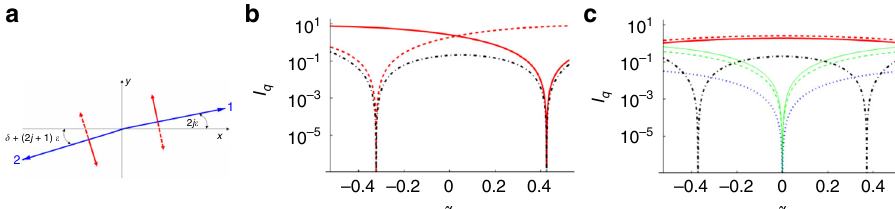
Fig. 6 Model predictions for the bilayer structure. a Molecules in the successive layers differ in the direction of the long molecular axis. The fi gure shows * the projection of the director n on the smectic plane ( xy -plane) in the jth stack of two successive layers; on the nearly anticlinic structure of the director in the neighboring layers, the additional rotation by angle ε is superimposed. Thick red (solid or dashed) arrows denote the direction of the molecular tip when the tilt is perpendicular to the tilt plane ( ϕ g equals 0 or π , see also Fig. 4), which de fi nes the sign of the layer chirality. b , c The intensities ( I q ) of the scattered light as a function of angle α de fi ning the molecular bend, at θ = 0.4, ε = 0.3, and δ = 0 for the peaks at q = q 2 + q m (red solid line: πσ or σπ - polarizations), q 2 − q m (red dashed line: πσ or σπ -polarizations), 2 q m (dash-dotted black line: σσ -polarizations), q 2 + 2 q m (solid green line: σσ -polarizations), q 2 − 2 q m (dashed green line: σσ -polarizations), and q m (dotted blue line: πσ or σπ -polarizations) for the structure b with preserved layer chirality between the neighboring layers and c with the layer chirality switch between the layers. For a structure with the chirality switch, we keep on a graph both the negative and positive part of α to emphasize the full symmetry of the graph with respect to this